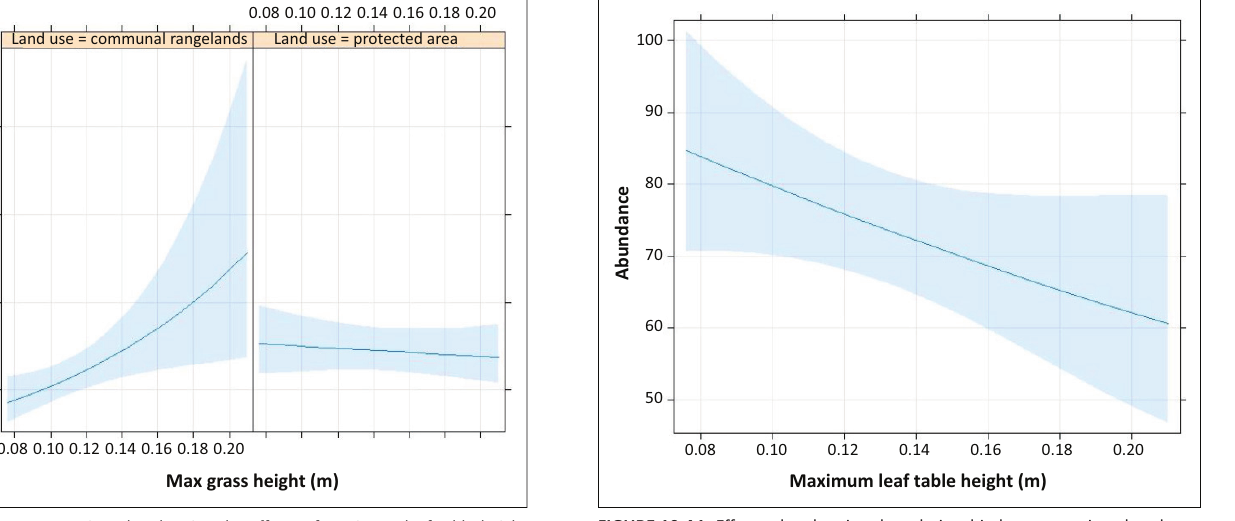
FIGURE 8-A1: Interaction plot showing the effects of maximum leaf table height (proxy for grass height), on avian species richness in different land-use types (protected areas versus communal rangelands). Light blue shading represents the 95 % confidence interval for the fitted model.